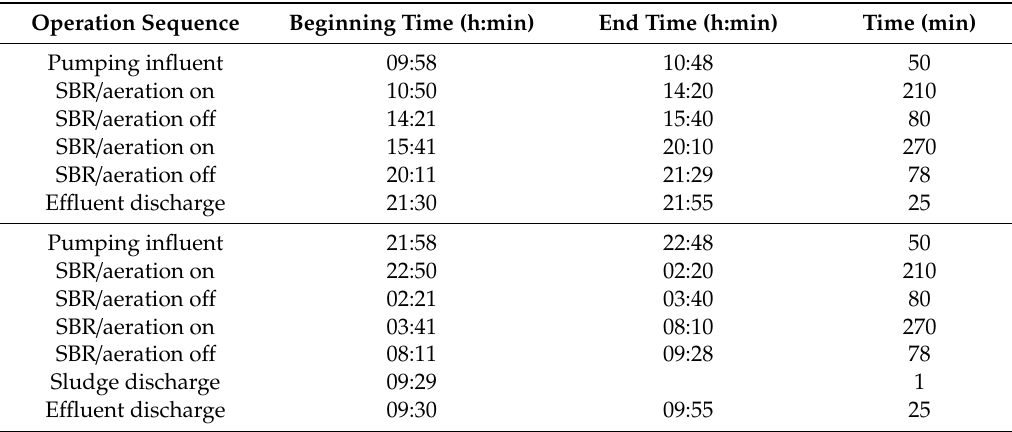
Table 1. The operation mode of the SBR system on site.